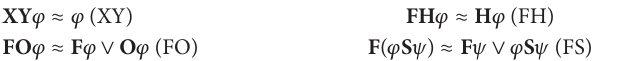
Table 4: Reduction rules for formulae involving (outermost) past operators.